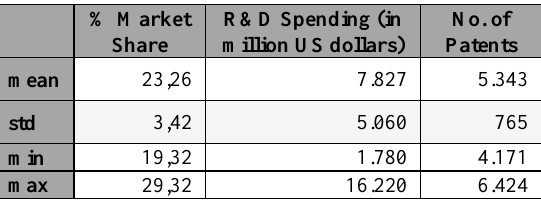
Table 13: Apple Descriptive Statistics